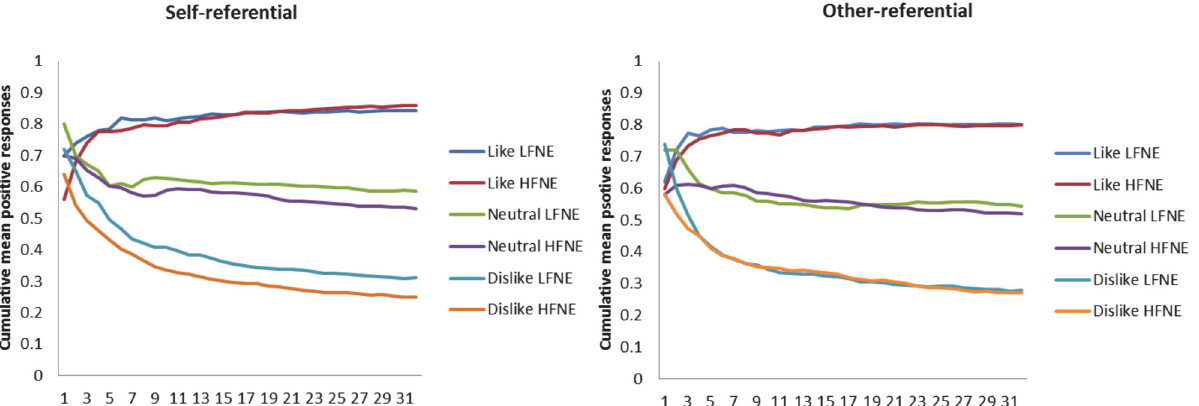
Fig 2. Cumulative mean positive responses over the 32 trials during the learning phase. Learning curves for high (n = 50) and low FNE (n = 50) individuals based on median split of test-day BFNE scores. The high and low FNE groups vary most over the initial trials where high FNE made fewer positive responses. After the initial trials the high and low groups behave similarly except in the neutral and dislike rules in the self-referential condition where the learning curves are clearly separated. The clear differentiation of the curves by rule indicates that individuals were adjusting their response in response to